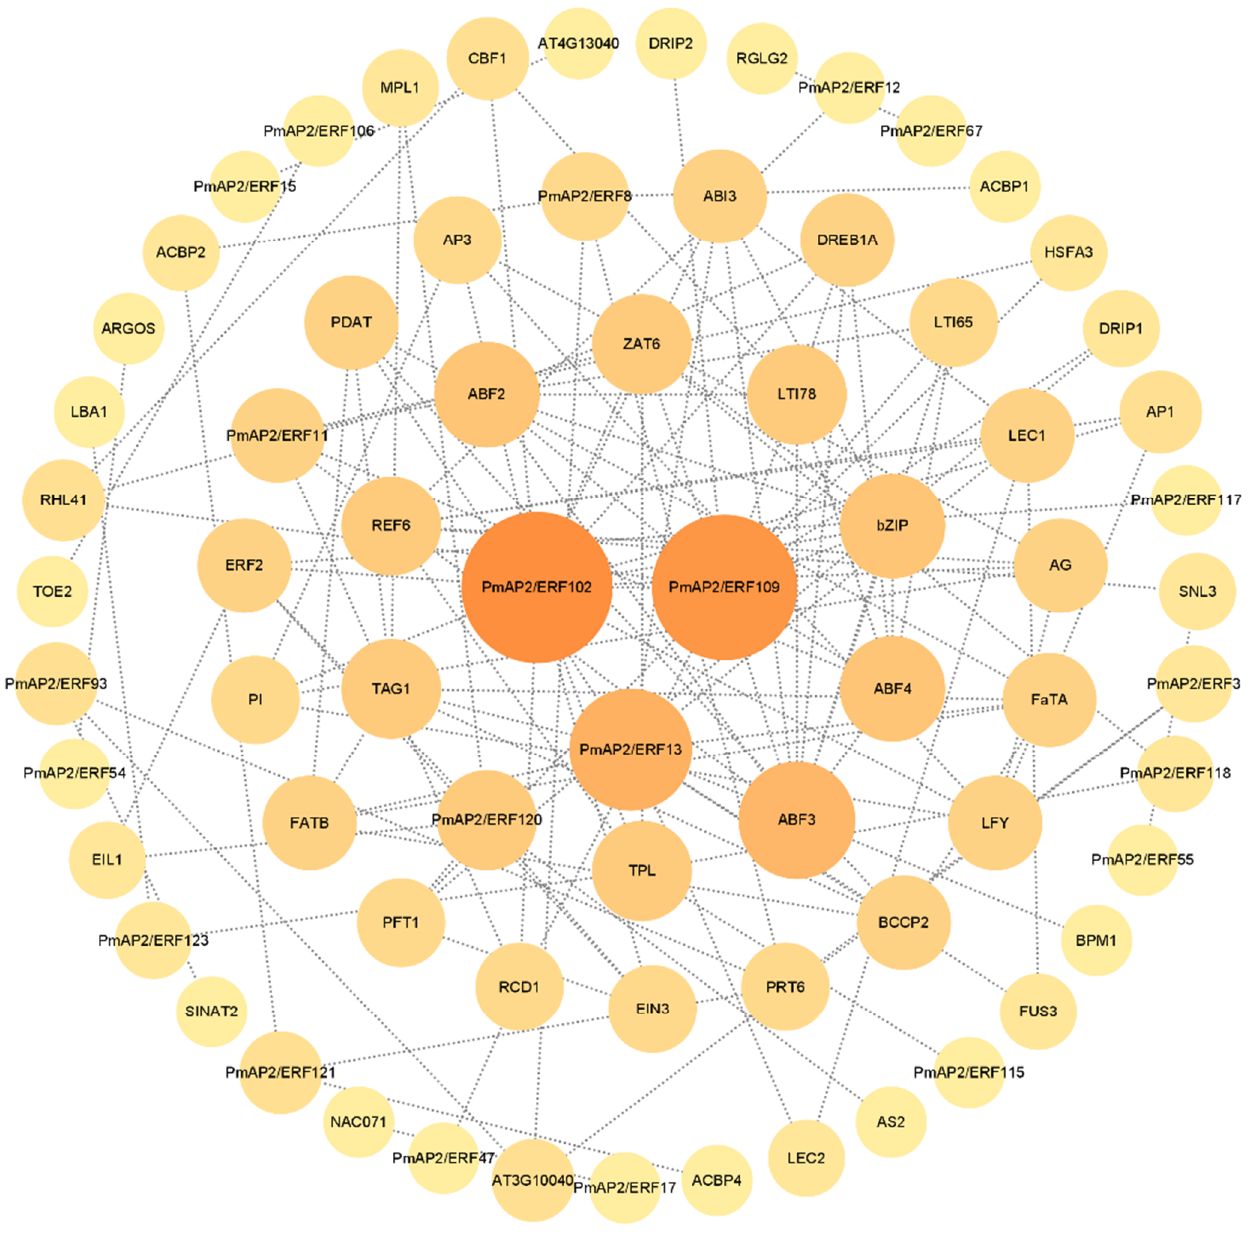
Figure 4. Prediction of the protein interaction network between PmAP2/ERFs of P. massoniana and AP2/ERFs of A. thaliana . The protein interaction network map of PmAP2/ERFs was constructed by STRING and Cytoscape software, which was based on the AP2/ERFs proteins of A. thaliana for analysis and prediction. The circles of different colors and sizes represent the importance of different proteins in the whole interaction network, and the dashed lines represent the possible interactions between the proteins.